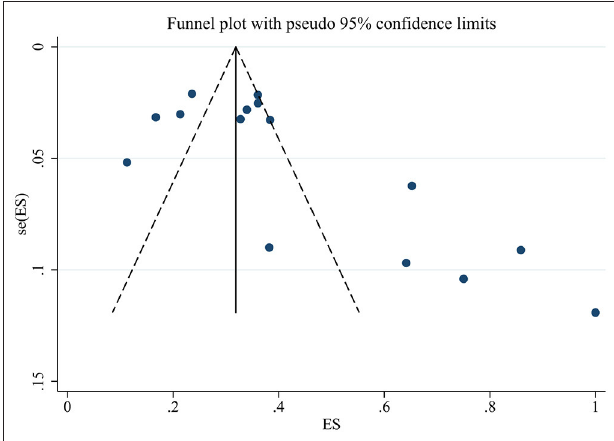
FIGURE 4 | Funnel plot of publication bias for the prevalence of sleep